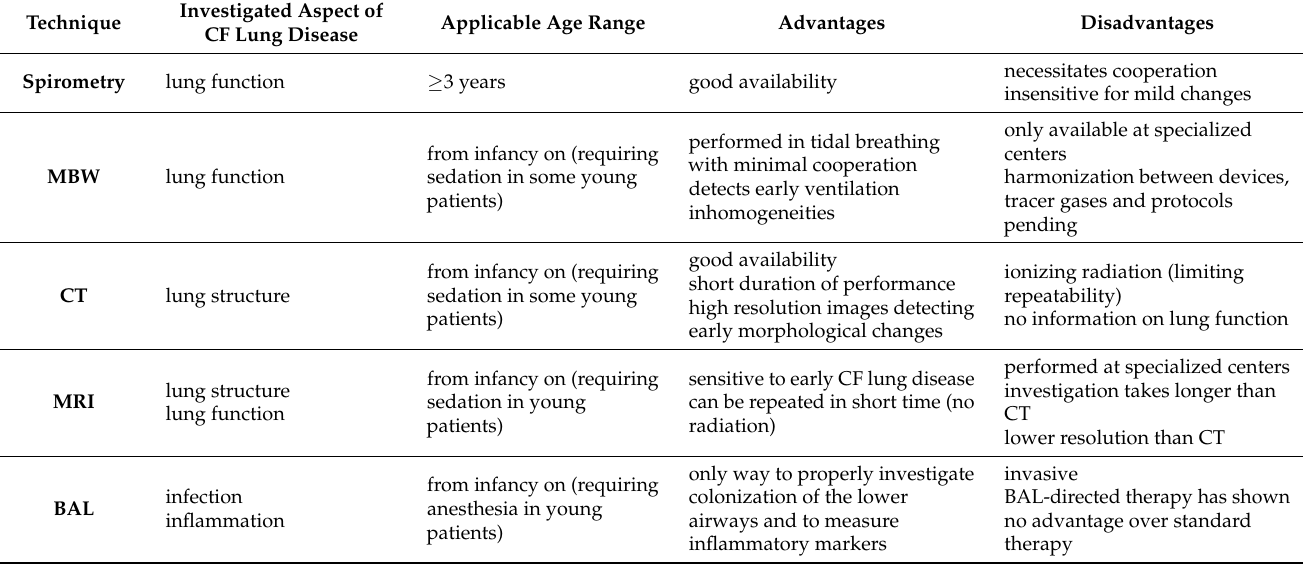
Table 1. Overview on outcome measures for investigation of early CF lung disease discussed in this review.